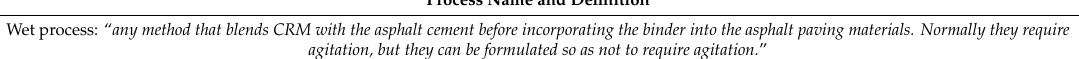
Table 1. Summary of name and definitions of the di ff erent processes and